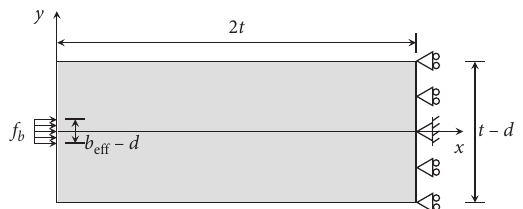
Figure 9: Alternative structural analysis model for anchorage zone with a duct hole (plan